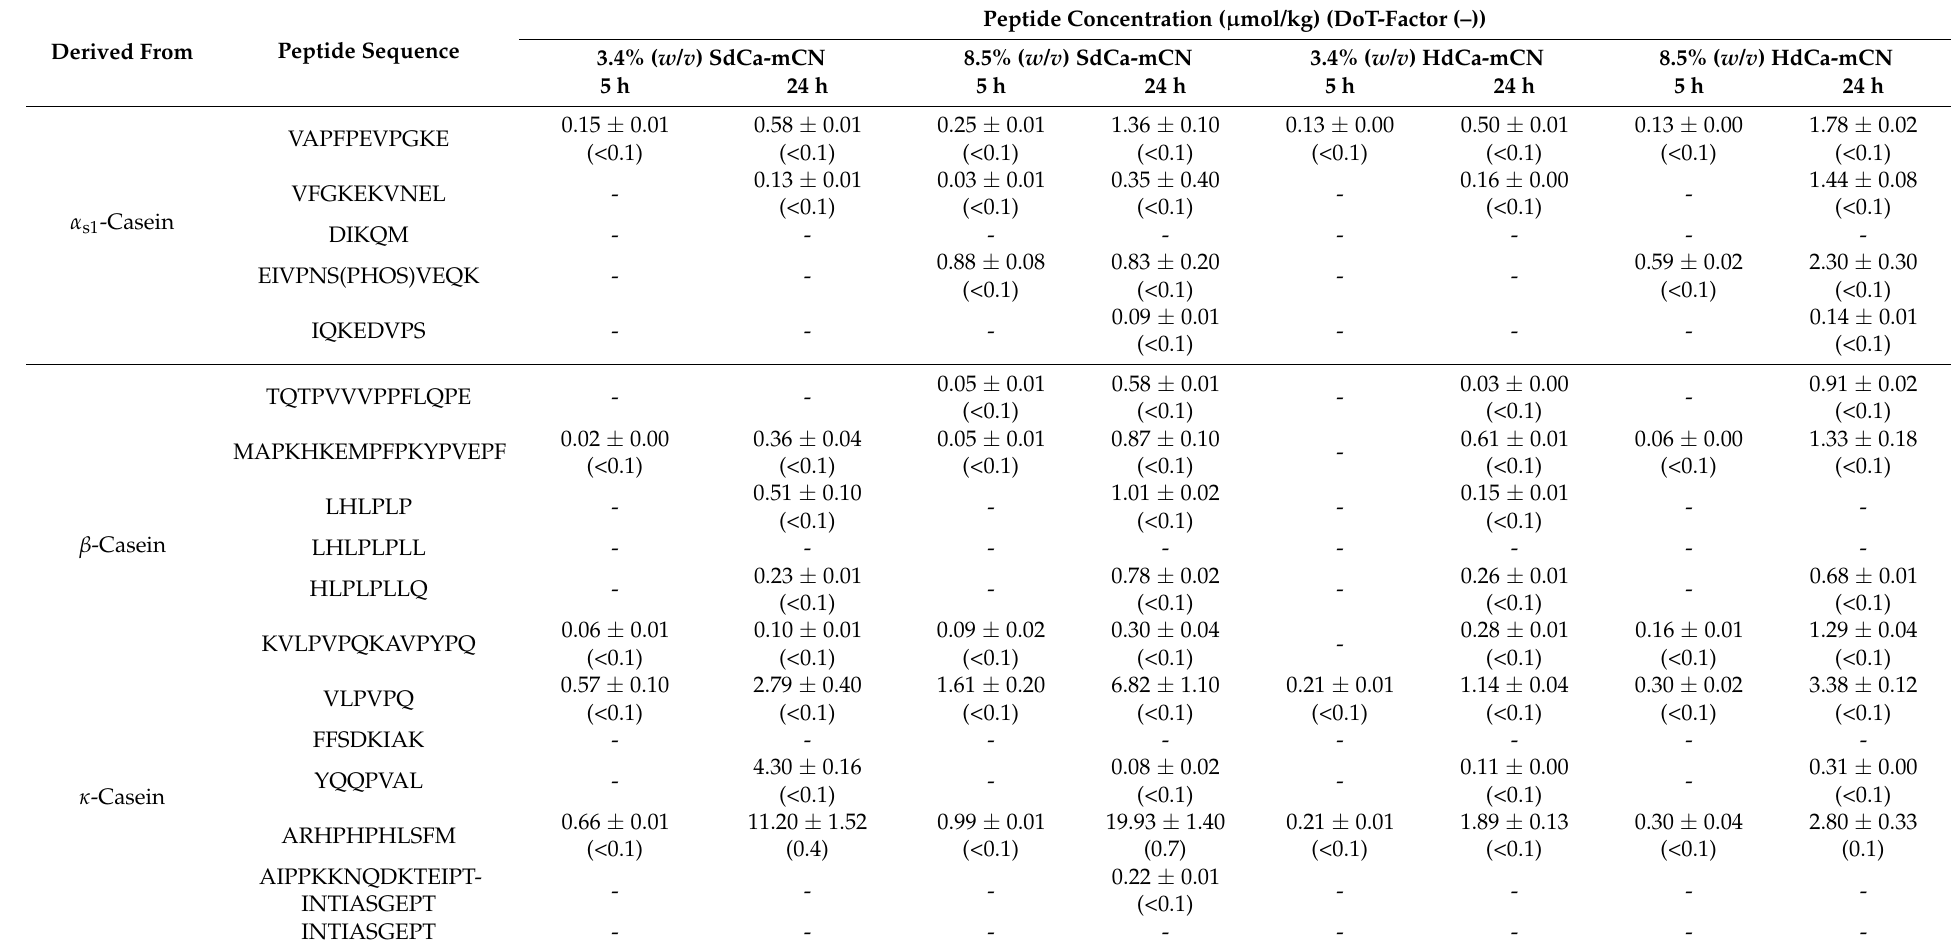
Table 4. Concentrations of key bitter peptides formed during cultivation of strain LTH 7122 in reconstituted casein medium with different protein and calcium concentrations and corresponding DoT factors. -: peptide concentrations too low for detection.